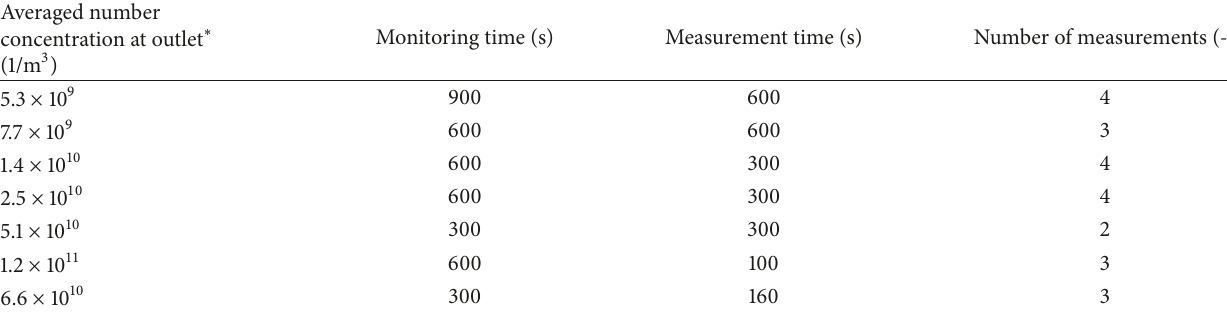
Table 4: Aerosol measurement information of the experiment